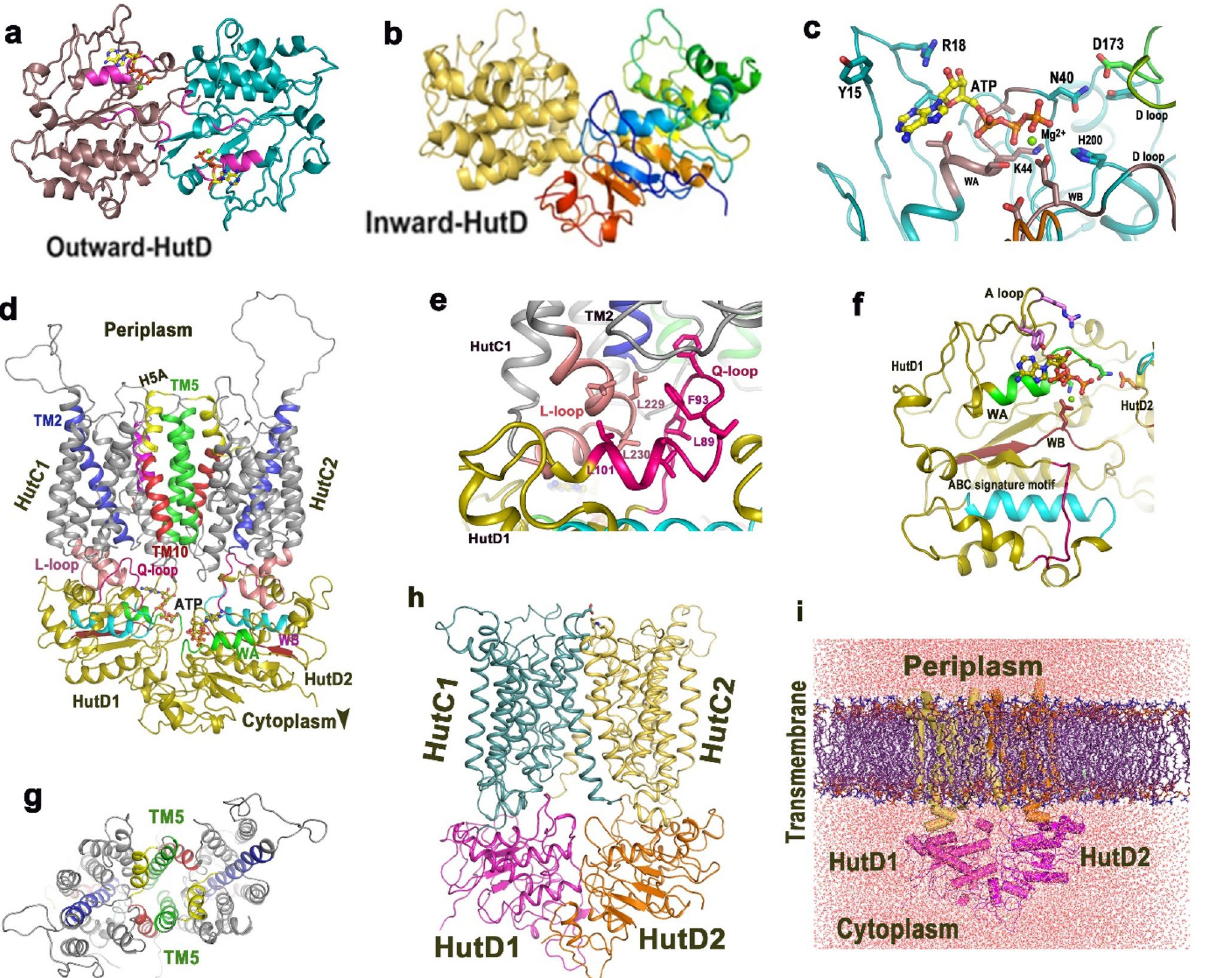
Figure 4. Models of HutD, HutC in different states and lipid embedded assembly. Ribbon representation of the models of ( a ) HutD dimer in the OF state, Nucleotide-binding domains (NBDs, dimer of HutD) are shown in brown and cyan, conserved Walker-A motif or P-Loop is shown in magenta of each NBD. Two ATP molecules are shown in stick; ( b ) HutD dimer in the IF state; ( c ) zoomed view of the docking of Mg 2+ -ATP in HutD OF dimer and related interactions; ( d ) Mg 2+ -ATP bound HutCD dimeric assembly in the OF state; zoomed view of different regions of HutCD are shown in ( e–g ). ( e ) Interactions between L-loop of HutC1 (salmon) with Q-loop of HutD1 (magenta); ( f ) disposition of binding motifs such as A-loop, Walker-A (green), Walker-B (maroon) around Mg 2+ -ATP. ABC signature motif is shown in cyan; ( g ) arrangements of transmembrane helices in HutCD-OF model is shown from the periplasmic side. TM5 helices of each TMD is shown in green, H5a in yellow; ( h ) Model of HutCD assembly in IF state. ( i ) Model of HutCD assembly embedded in solvated DMPC lipid